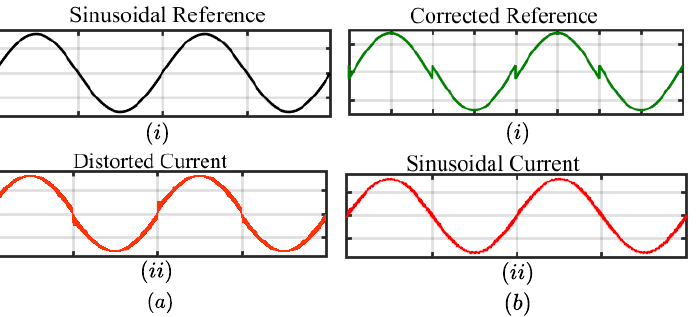
Figure 7. Sketch of inductor current over a line cycle with ( a ) Sinusoidal reference. ( b ) Corrected reference. The amplitude of ∆ i Lpp obtained by (7) is not the same throughout the line cycle, but varies with v g as shown in Figure 8, where it is highest at zero-crossing of v g and the lowest at v g peak.